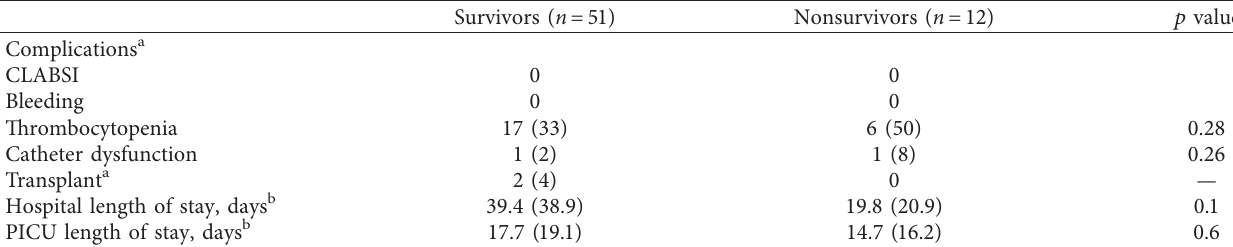
Table 3: Patient